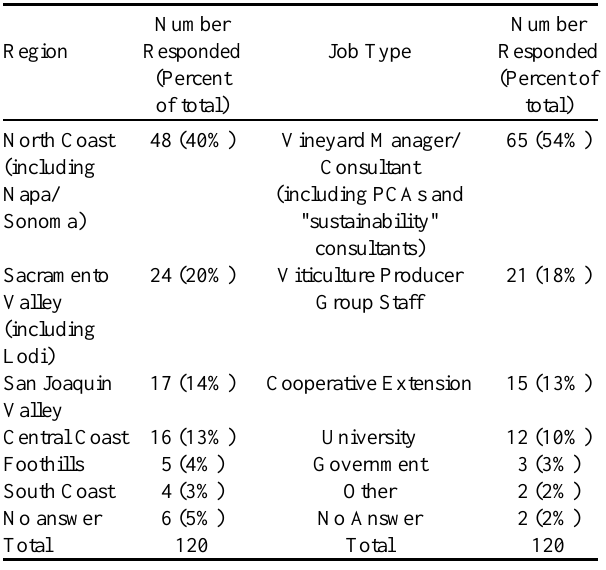
Table 2. Number of responses by region and job type.